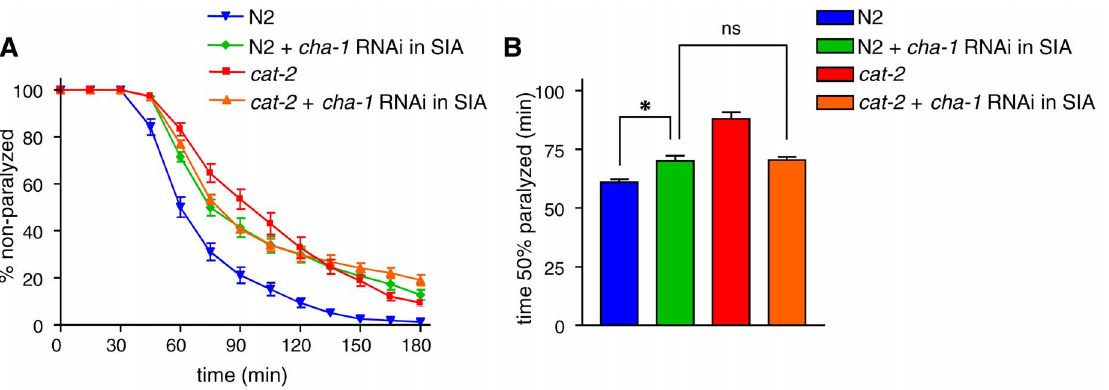
Figure 5. cha-1 RNAi in wild-type and cat-2 mutant animals. The choline acetyltransferase gene cha-1 was specifically knocked down by RNAi in the SIA neurons of wild-type N2 animals or in the cat-2 mutant. (A) The animals were examined for paralysis on NGM plates containing 1 mM aldicarb. (B) The time required for 50% of the animals to become paralyzed was determined using Prism. cha-1 RNAi in SIA neurons resulted in increased aldicarb resistance in a wild-type background. The cat-2 mutation did not significantly alter aldicarb sensitivity when cha-1 was knocked down in SIA neurons. *P , 0.001, ns: P . 0.05, by the Tukey-Kramer multiple comparison test. Error bars indicate the SEM.